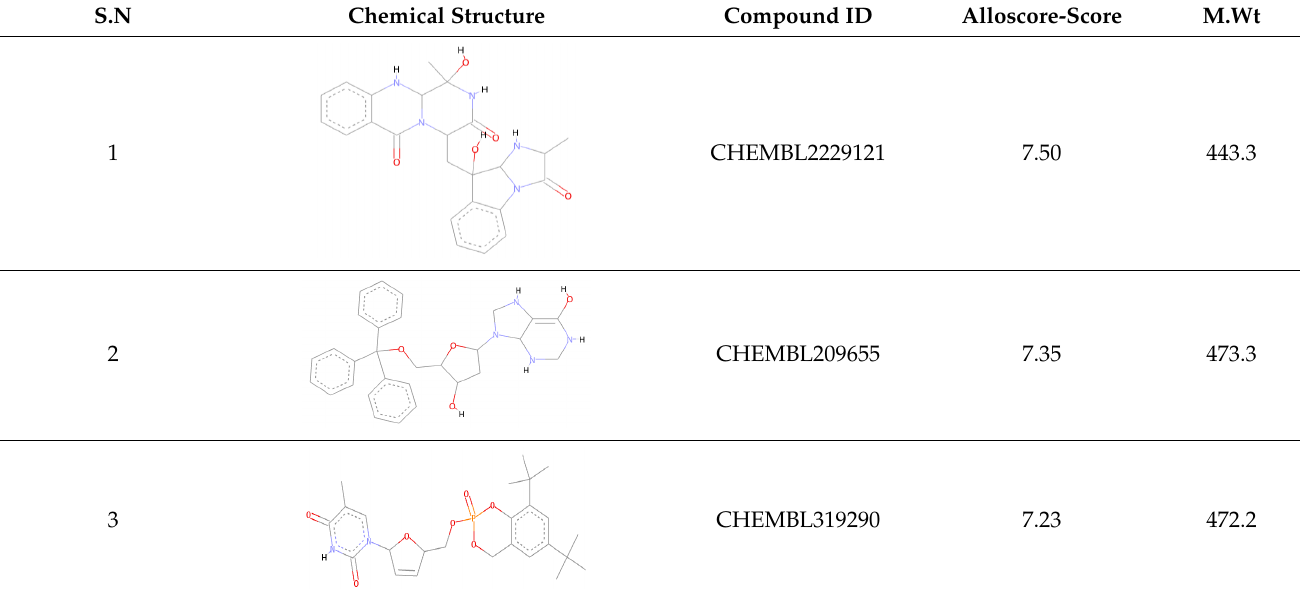
Figure 3. ( A ) Represents the 3- (Upper panel) and 2-dimensional (Lower panel) interactive poses of CHEMBL2229121, while ( B , C ) are the representations of CHEMBL209655 and CHEMBL319290 with the SARS-CoV-2 MTase allosteric site, respectively. Table 3. Chemical structures, compound IDs, molecular weights, and alloscore-score rankings from the CHEMBL Diversity Library.